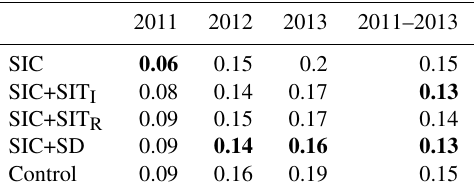
Table 5. The yearly averaged RMSE values of the five experiments compared to the IMB snow-depth buoy observations. Bold values represent the model with the lowest RMSE values for that year. No uncertainties are used to normalise the RMSE